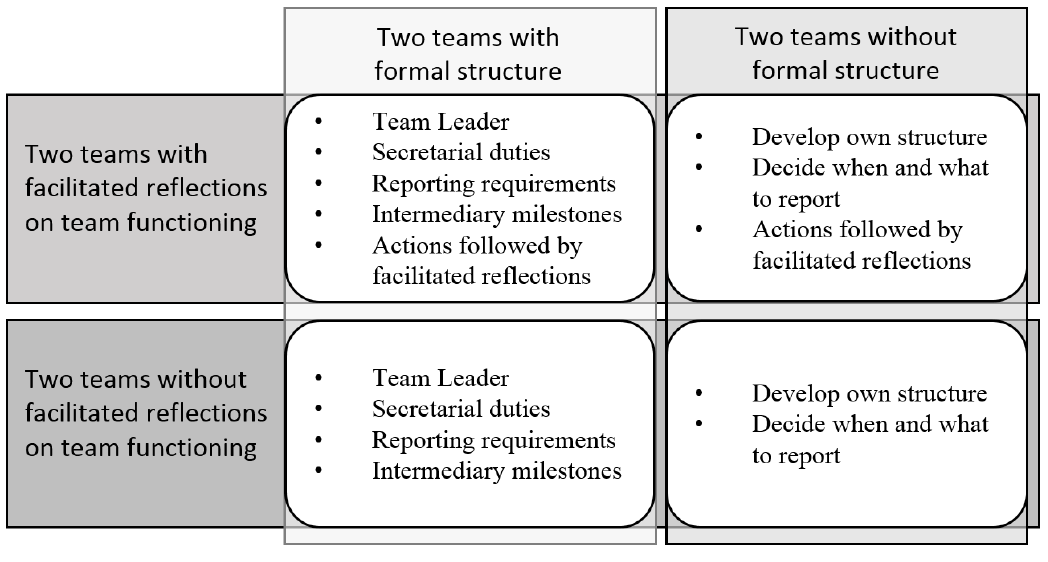
Figure 2. Virtual team structures (source: authors).